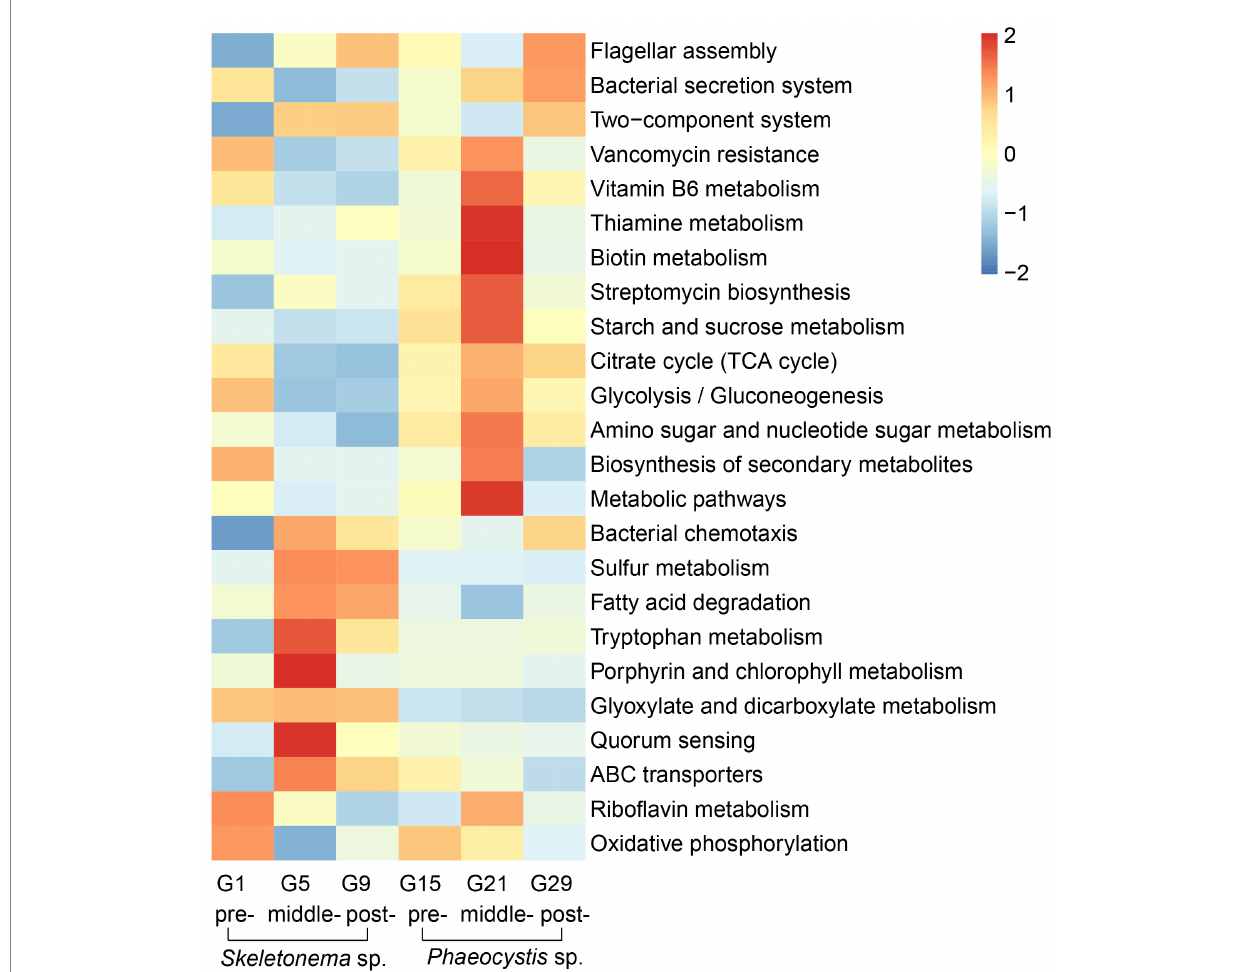
FIGURE 6 KEGG functional annotation and trends during the algal bloom with z-score values of each KEGG pathway across the rows. The red color indicates high abundance, and blue indicates low